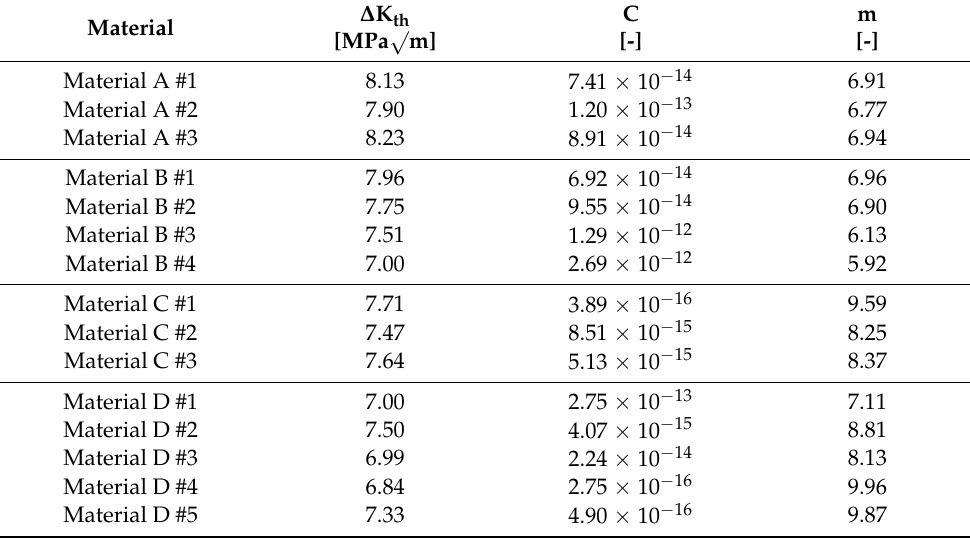
Table 2. Summarized results for the fatigue crack growth threshold stress intensity factor range ∆ K th and the parameters C and m describing fatigue crack growth in the early Paris regime.